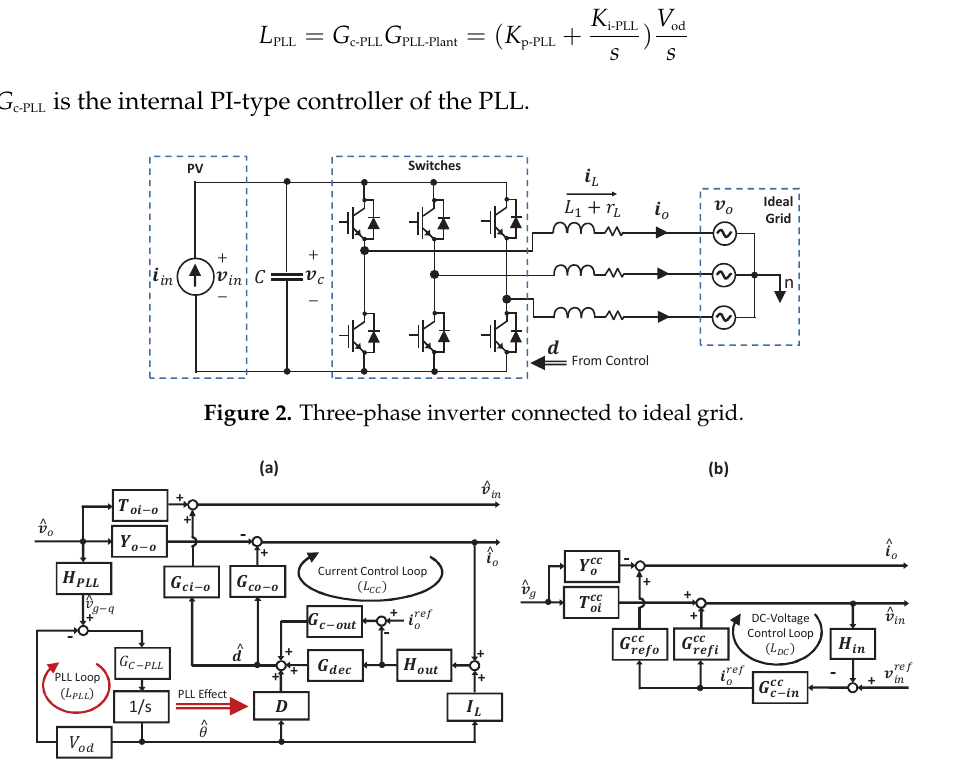
Figure 3. Inverter dynamics including ( a ) phase-locked loop (PLL) and current-control loops, and ( b ) closed-loop transfer functions and DC-voltage control